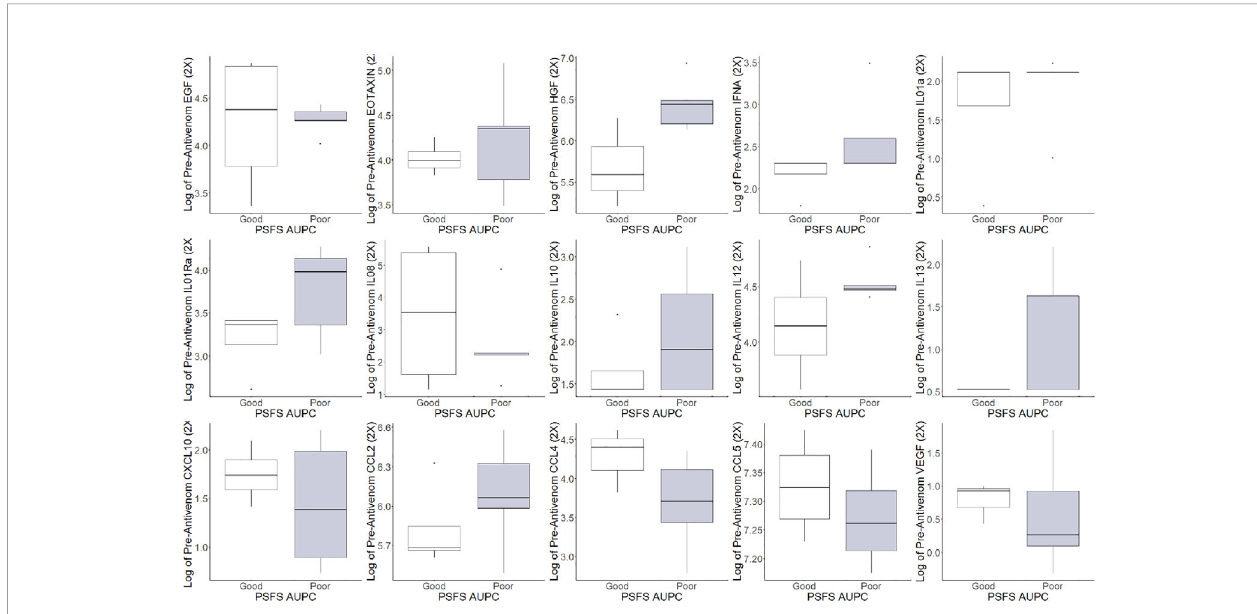
FIGURE 3 | Pre-antivenom cytokines and chemokines values of patients with good and poor recovery. EGF: endothelial growth factor, *EOTAXIN: eosinophil chemotactic proteins, *HGF: hepatocyte growth factor, IFNA: interferon alpha, IL01a: interleukin 1a, IL01Ra: Interleukin 1 receptor antagonist, IL08: interleukin 8, *IL10: interleukin 10, *IL12: interleukin 12, IL13: interleukin 13, *CXCL10: C-X-C motif ligand 10, *CCL2: C-C motif ligand 2, *CCL4: C-C motif ligand 4, *CCL5: C-C motif ligand 5, *VEGF: vascular endothelial growth factor. *Difference in populations based on box